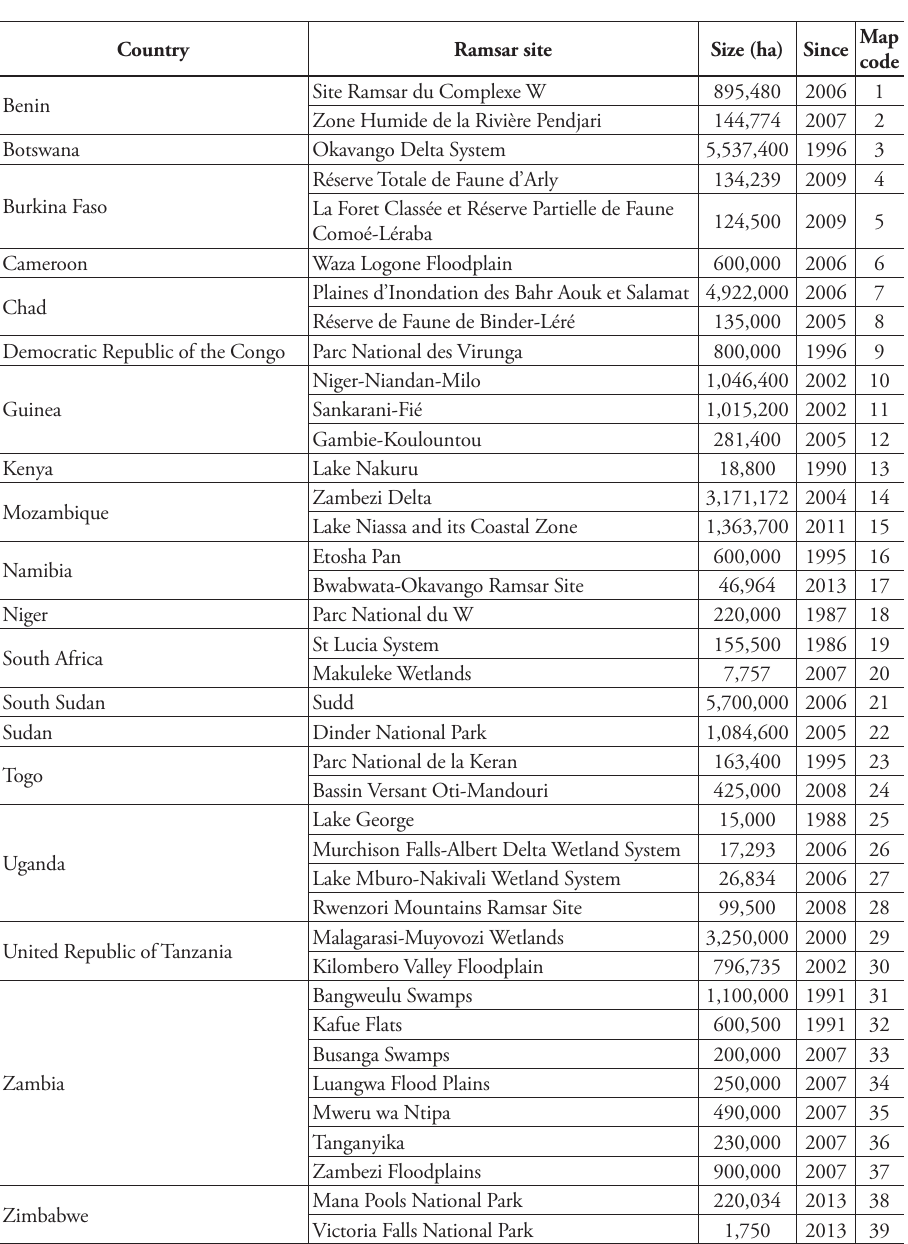
Table 3. Ramsar sites of importance to lion conservation. Whereas most of these sites currently have lions, some sites have been included from which lions have disappeared in the recent past. Map codes indicate the sites’ geographic locations as shown in Figure 1. For more detailed information on each site, including the reasons for listing and precise location and delimitation, see the Ramsar Sites Information Service database: